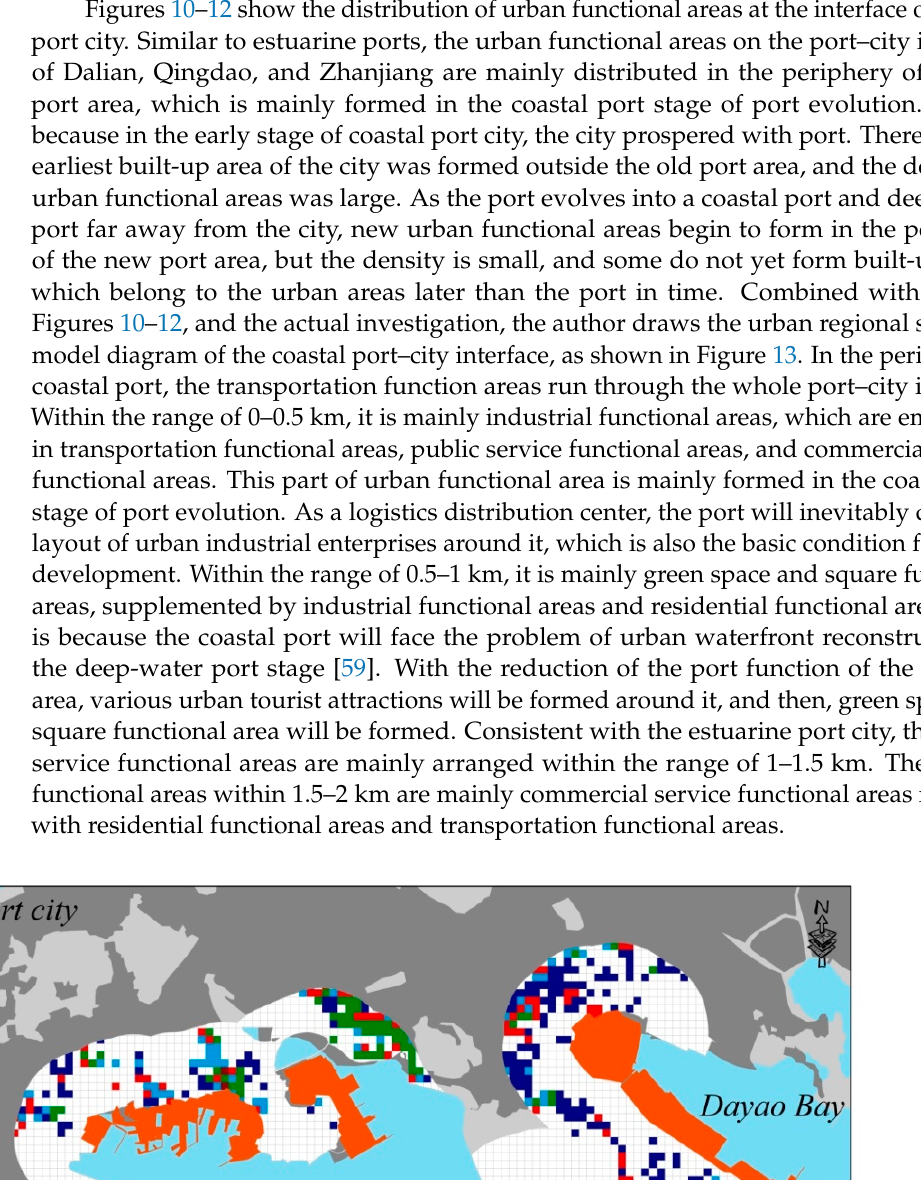
Figure 11. Distribution of urban functional areas on the Qingdao port–city interface (source: drawn by author).